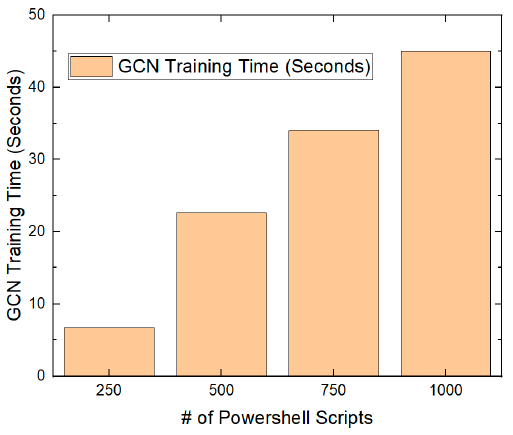
Figure 12. GCN training time.